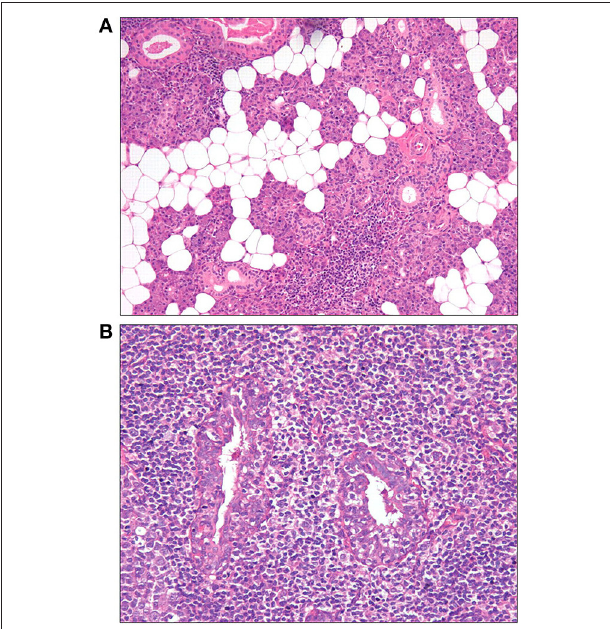
FIGURE 2 | Histopathological features of the parotid gland tissue stained with hemoglobin and eosin staining ( 57). (A) Adipose infiltration and periductular lymphocytic infiltrates (10 × ). (B) Lymphoepithelial lesions (LELs) surrounded by lymphocytic infiltrates (20 ×